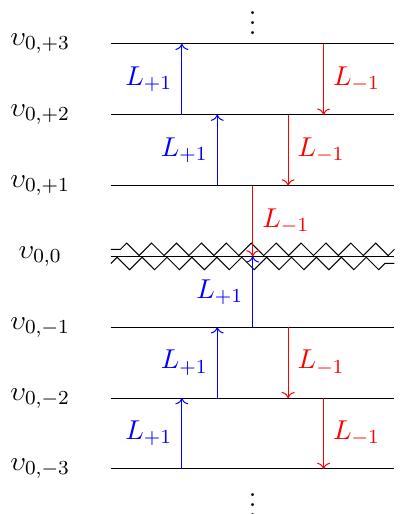
extension of the V